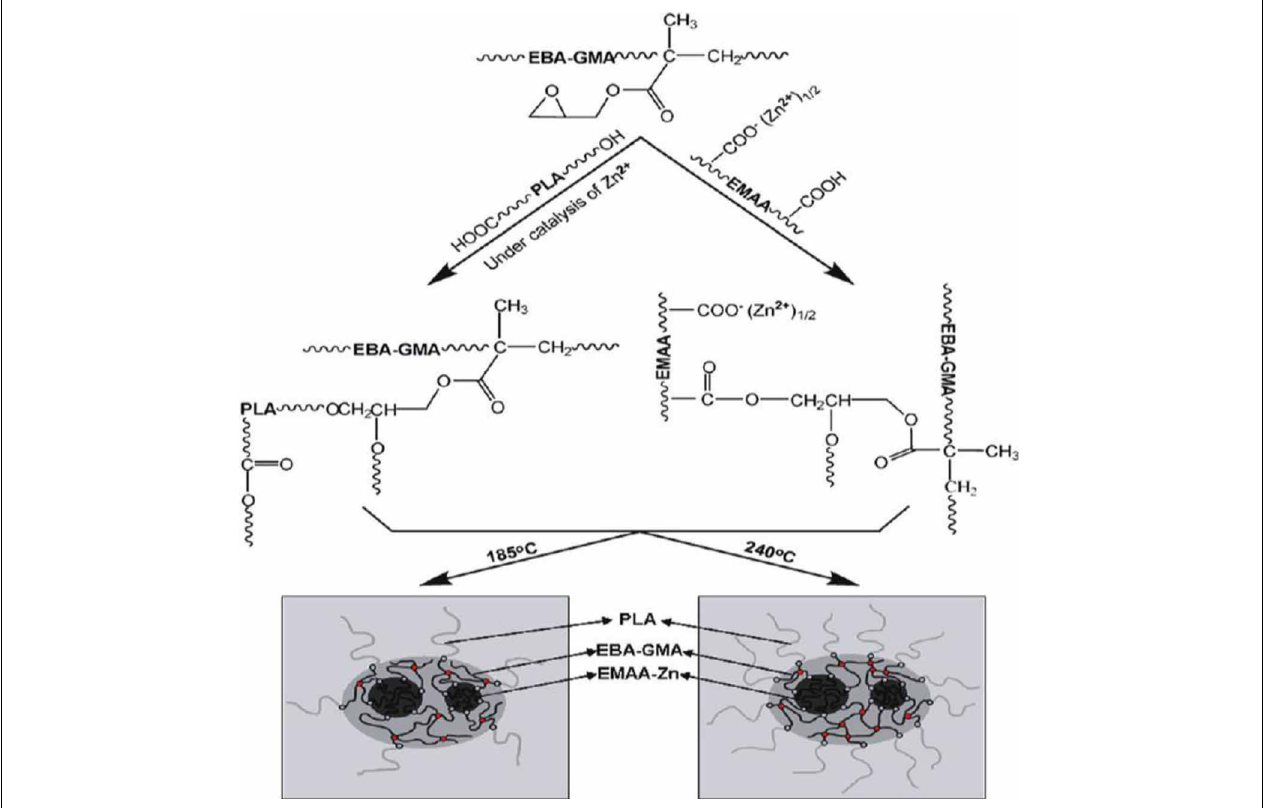
FIGURE 20 | Proposed reactions during the reactive blending process, together with schematic phase morphologies of the PLA/EBA-GMA/EMAA-Zn ternary blends extruded at 185 and 240 ◦ C respectively. Adapted with permission from Liu et al. (2010).